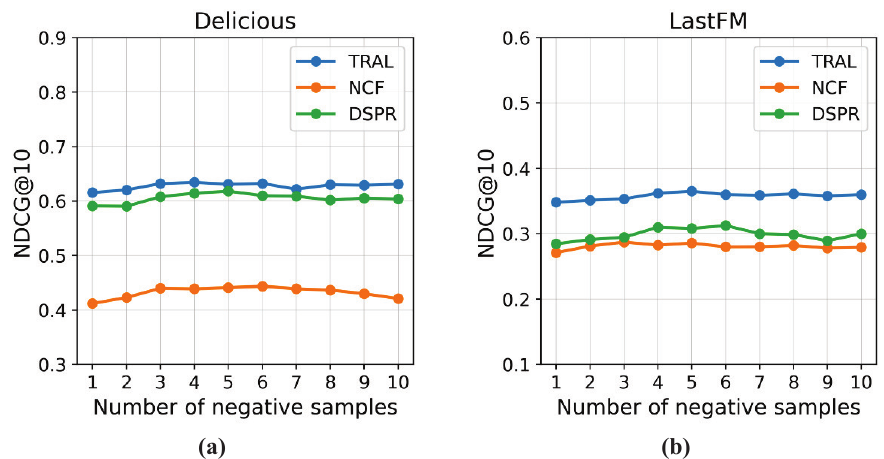
Figure 5. Recommendation results of different number of negative samples. ( a ) NDCG@10 on Delicious. ( b ) NDCG@10 on LastFM.